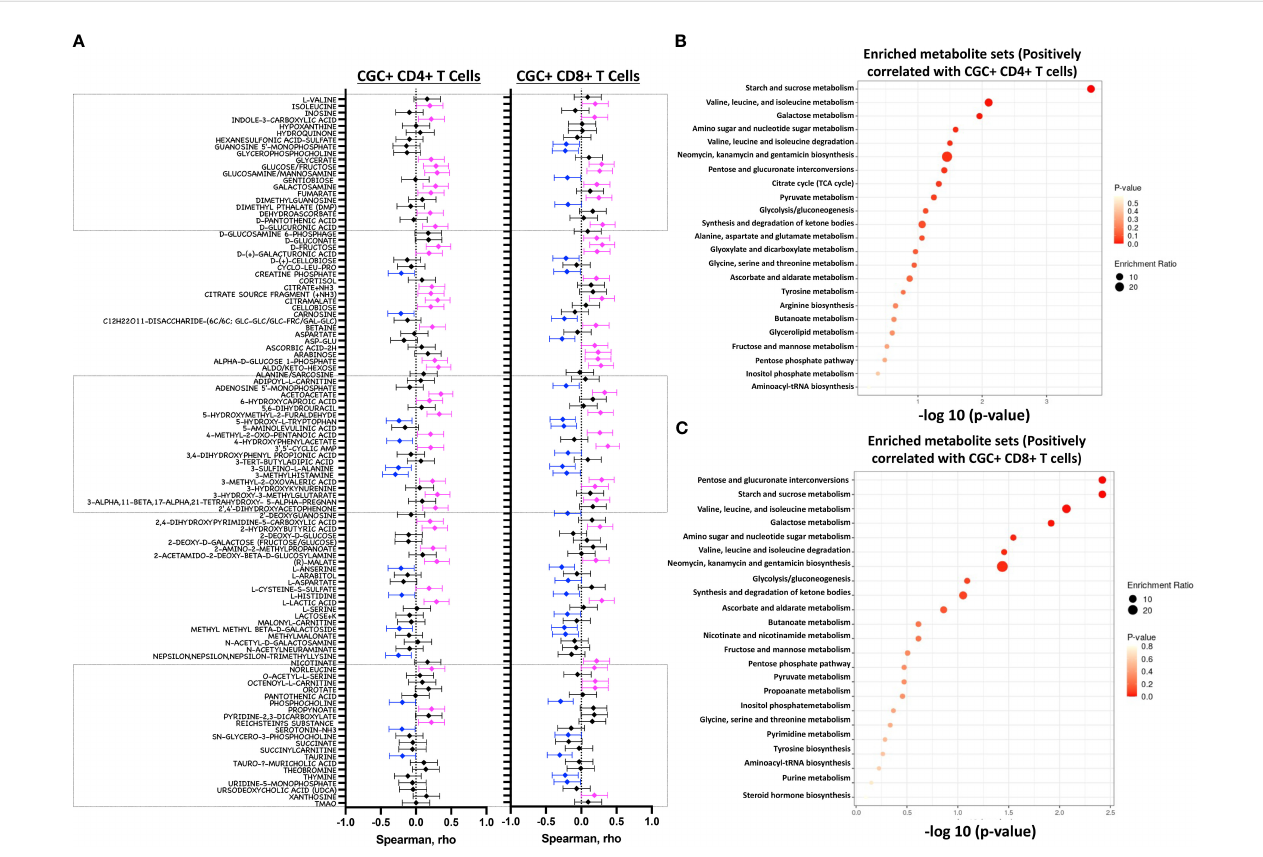
FIGURE 10 Starch and sucrose metabolism pathways are enriched among plasma metabolites positively correlated with CGC + T cells. Forest plots showing Spearman ’ s rank correlation coef fi cients between plasma metabolites and the proportion of CGC + CD4 + T cells over total CD4 + T cells (left panel) and % CGC + CD8 + T cells over total CD8 + T cells (right panel) (A) . The top twenty- fi ve metabolite sets in the enrichment analysis (number of metabolites/expected metabolites per set) were determined based on metabolites that were positively correlated with % CGC + CD4 + T cells (B) and % CGC + CD8 + T cells (C) . Statistical analysis by Spearman ’ s rank correlation. Color code: Blue, negative correlation p<0.05; Magenta, positive correlation p<0.05; black, non-signi fi cant correlation. Over Representation Analysis (ORA) of plasma metabolites that were associated with CGC + T cells was performed using MetaboAnalyst 5.0 with the hypergeometric test. One-tailed adjusted p values are provided after correcting for multiple